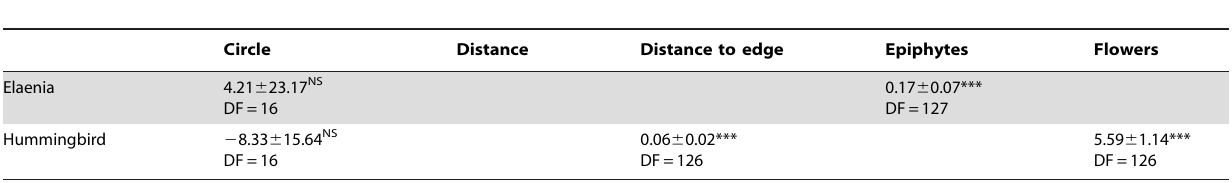
Table 2. Results of Generalized Linear Models for the effect of selected patch characteristics on point-level bird density (parameter estimates 6 standard